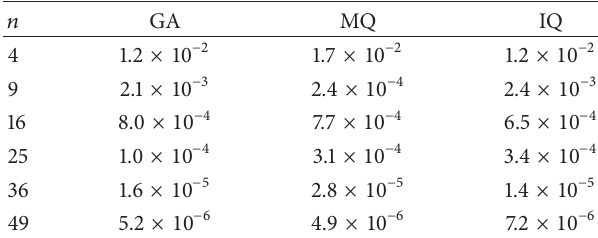
Table 3: Numerical results of different RBFs for Example 3. The roots of Legendre polynomial are chosen as the center points.